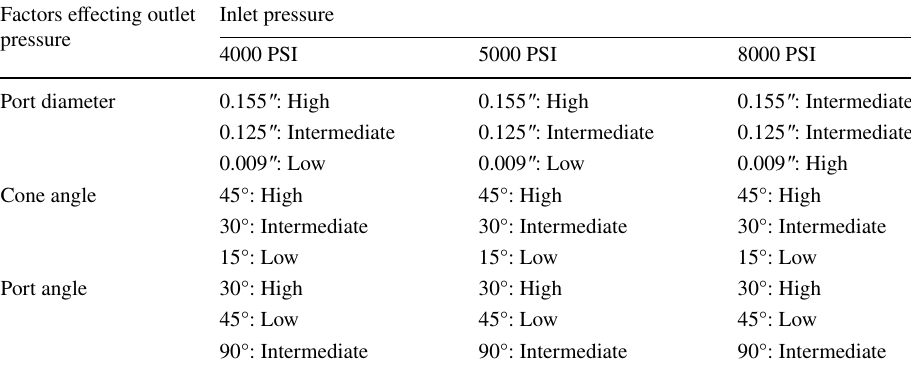
Table 5 Effects of port